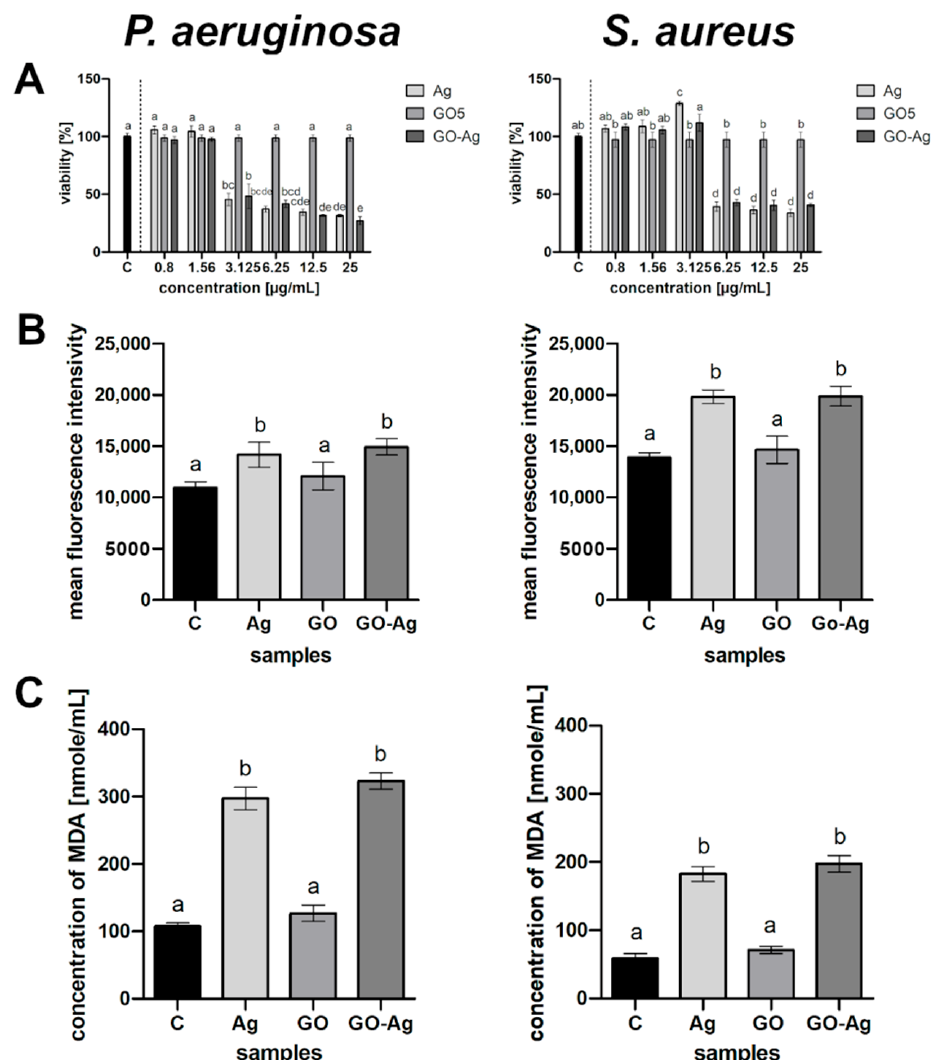
Figure 5. Metabolic activity of bacteria after treatment with silver nanoparticles (Ag), graphene oxide (GO) and GO with AgNP complexes (GO-Ag) in relation to control (C): ( A ) viability determined by XTT analysis, column C is control; ( B ) generation of reactive oxygen species; ( C ) lipid peroxidation determined by MDA assay. The columns are mean values; error bars are standard deviations; different letters (a–e) indicate significant differences between groups within bacteria species ( p -value ≤ 0.05).